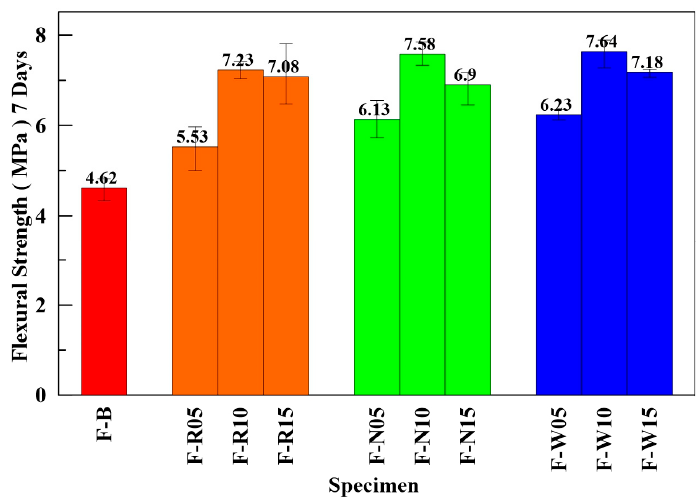
Figure 11. Average flexural strength of ECFRC and benchmark specimens.